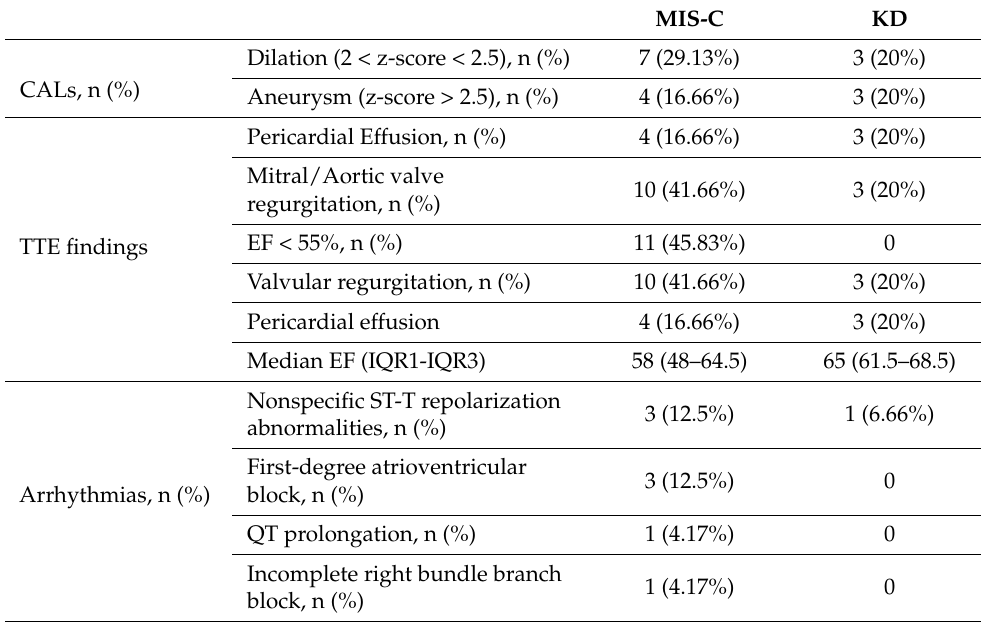
Table A1. Features of cardiac involvement in MIS-C and